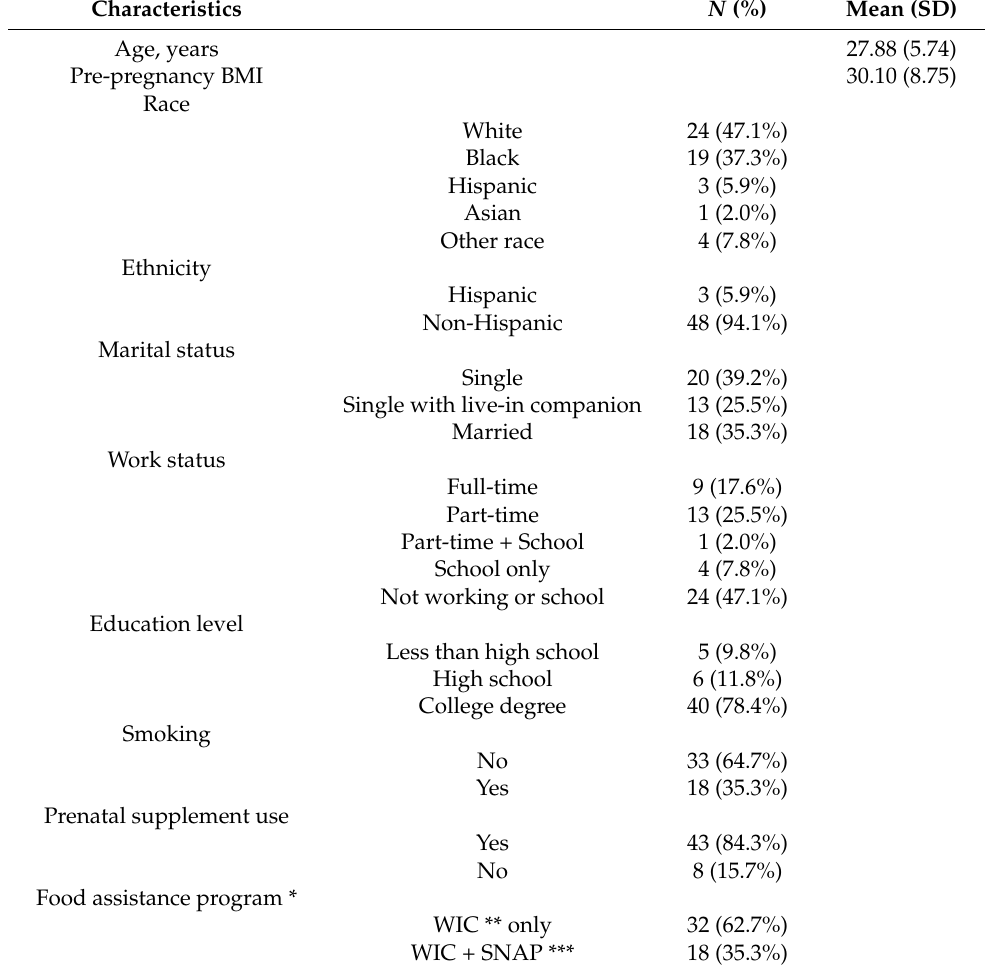
Table 1. Maternal characteristics of study participants ( n =